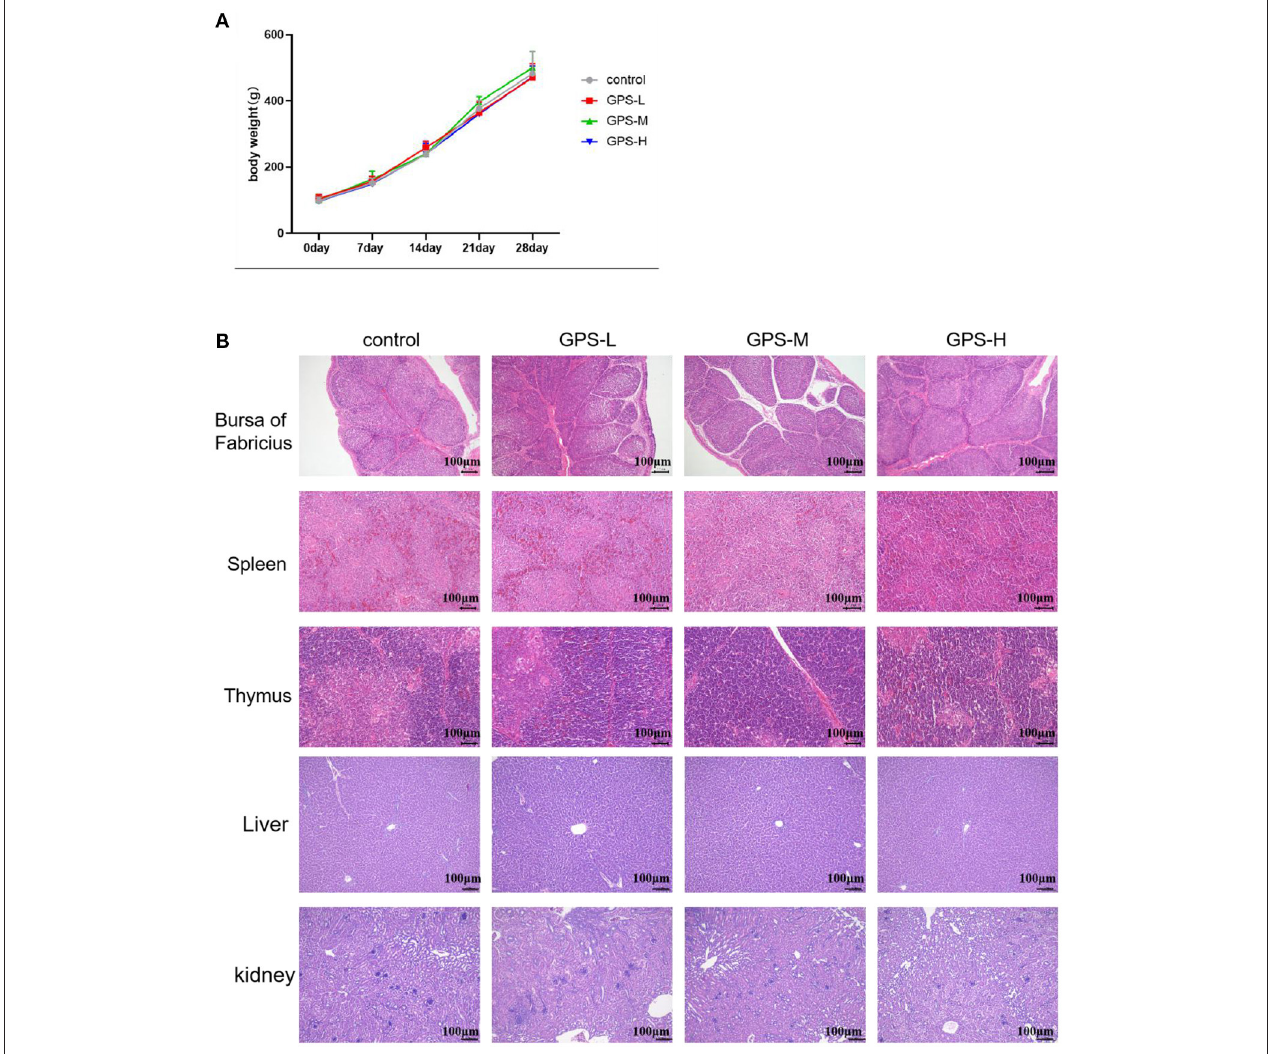
FIGURE 9 | Examination of potential toxicity of GPS on roosters. (A) The influence of GPS on body weight. (B) The influence of GPS on immune organs (bursa of Fabricius, spleen, thymus, liver, and kidneys) after 14 days (100 × magnification, 100 µ m scale bar).